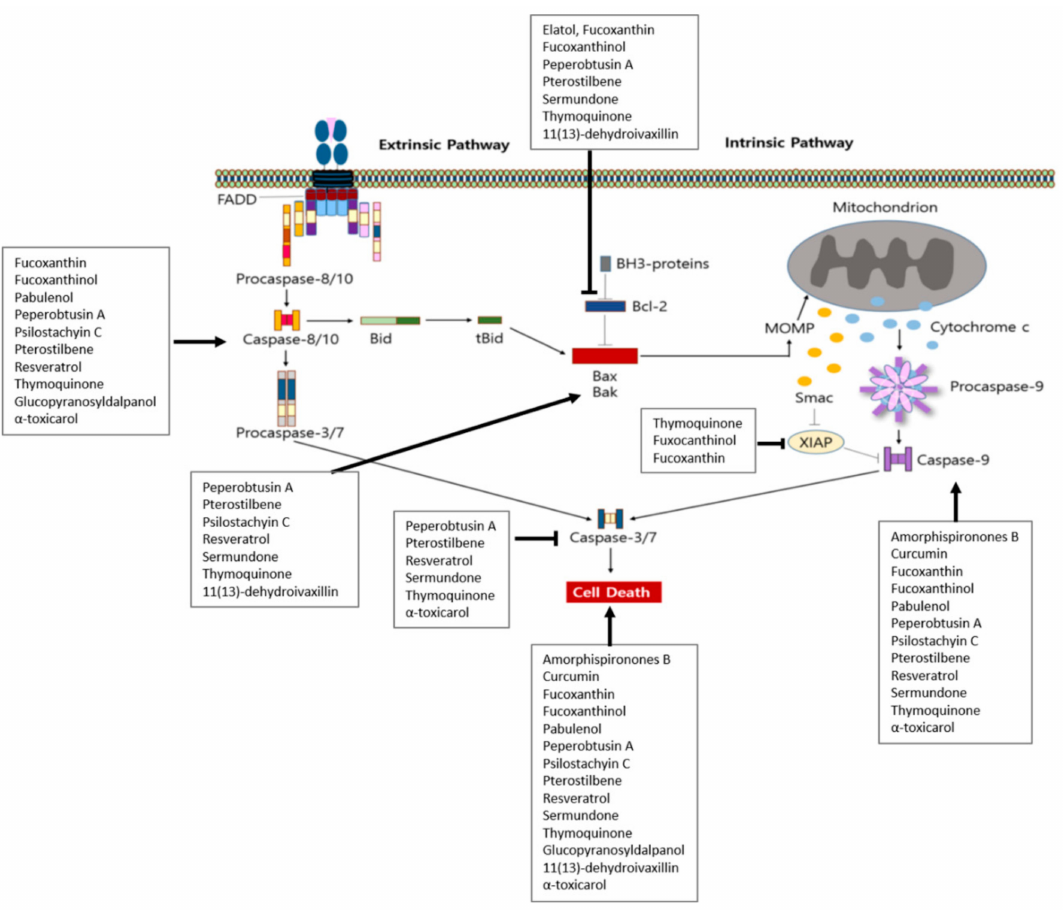
Figure 2. Schematic diagram of natural product-induced